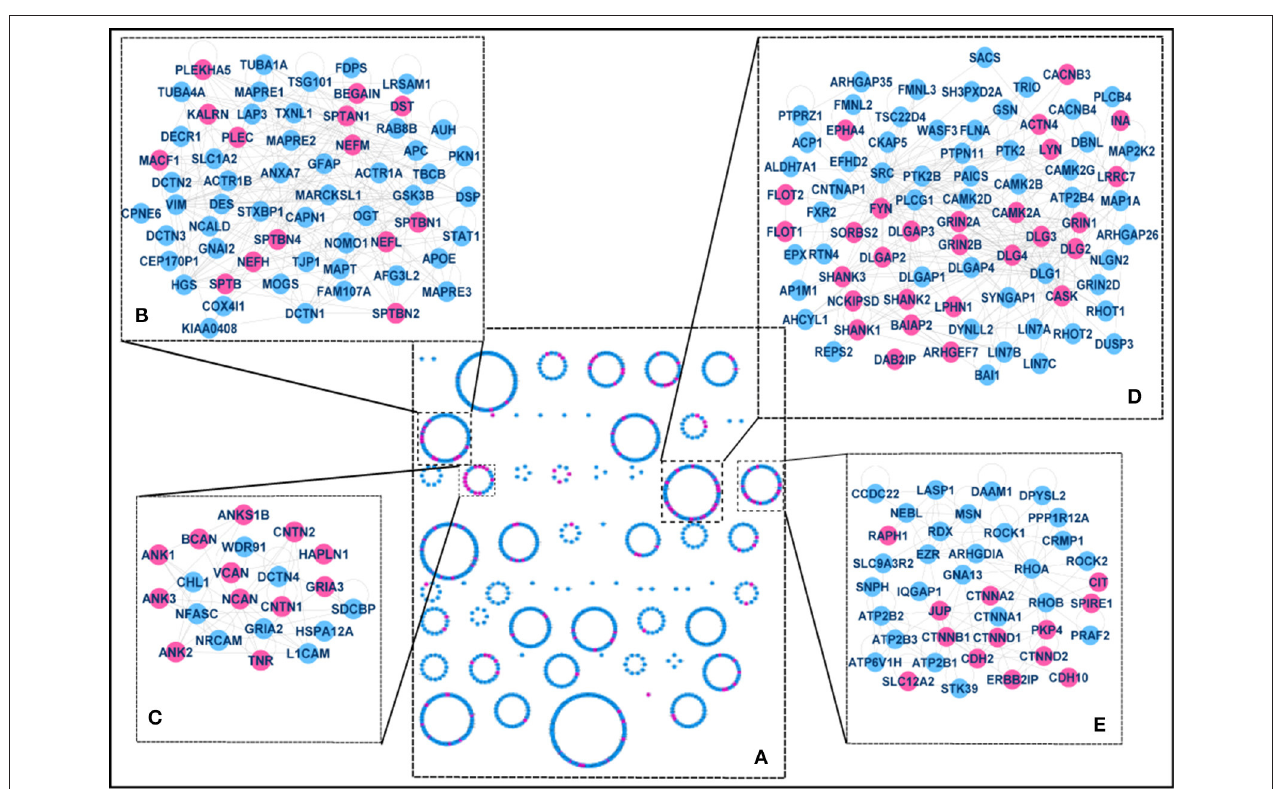
FIGURE 4 | The p140Cap-interactome within the PSD (A) Clusters in the full PSD network. 60 structural clusters where obtained, including 4 significantly enriched for p140Cap–interacting proteins (purple), magnified in panels B–E. (B) Components of Cluster 7. The cluster is overrepresented with “cytoskeleton organization,” “actin cytoskeleton organization,” and “cell junction assembly” terms and contains p140Cap interactors from Module 3. (C) Components of Cluster 17. This cluster is associated with trans-synaptic signaling and contains p140Cap interacting proteins from Module 3. (D) Components of Cluster 22. The cluster includes the main MAGUK and scaffold proteins and associated with “glutamate receptor signaling pathway,” “endocytosis,” “cell-cell signaling,” and “synaptic transmission” terms and contains the majority of the proteins from Module 1. (E) Components of Cluster 23. The cluster is associated with cell adhesion function and cell junction functions and is enriched with proteins from Module